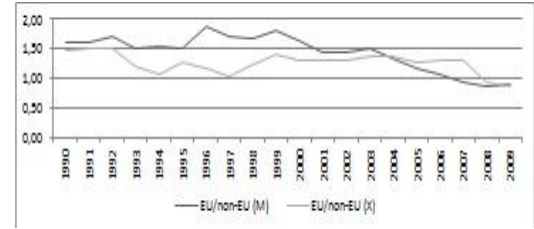
Figure 2. The Import and Export Ratio of EU Countries to Non-EU Countries